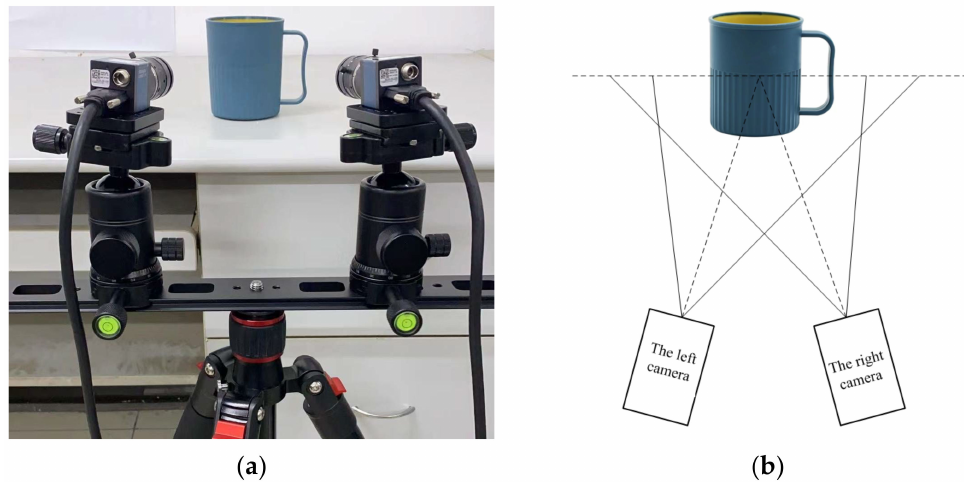
Figure 4. Experimental setup: ( a ) binocular system; ( b ) measurement